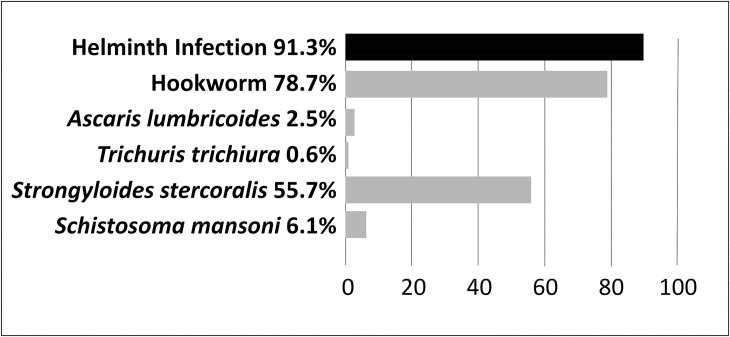
Helminth infections in the 792 participants.In the top, (black) the overall helminth prevalence. At the bottom (grey colour) prevalence of the soil transmitted helminths, (including Strongyloides stercoralis), Schistosoma mansoni, and other minor findings mentioned in the text.